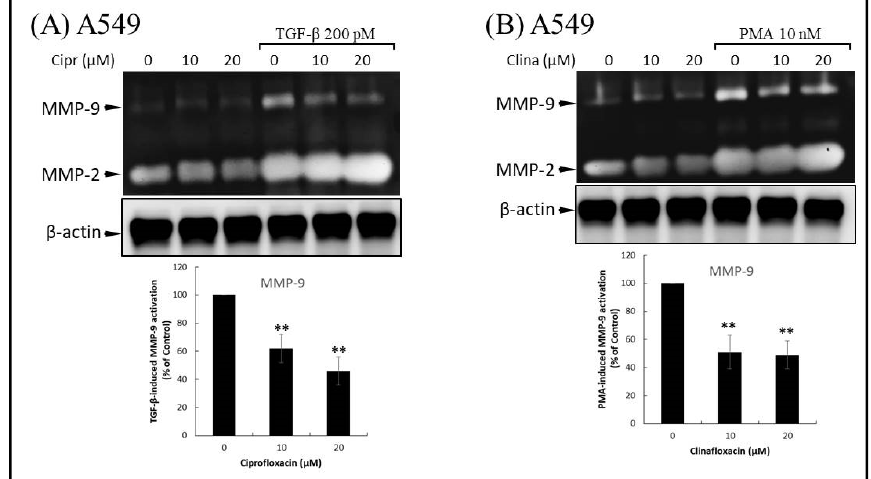
Figure 2. Fluoroquinolones (FQs) inhibit extracellular secretion of matrix metalloproteinase-9 (MMP-9). ( A ) Ciprofloxacin inhibits transforming growth factor beta (TGF- β )-stimulated gelatinolytic activity of MMP-9. A549 cells were pre-treated with ciprofloxacin for 1 h and subsequently treated with TGF- β for an additional 48 h. Conditioned medium was collected for gelatin zymography analysis of gelatinolytic activities. ( B ) Clinafloxacin reduces phorbol 12-myristate 13-acetate (PMA)-induced extracellular secretion of MMP-9. A549 cells were treated with clinafloxacin for 1 h, and then stimulated with 10 nM PMA for 24 h. Representative gelatin zymography images are shown in the upper panel. The MMP-9 activities of the FQ-treated groups were expressed as a percentage of the MMP-9 activity in TGF- β or PMA-treated cells (lower panel). The results are expressed as means ± standard deviation (error bars) of three independent experiments. Statistically significant differences of zymographic activities were indicated as percentage vs. PMA or TGF- β -stimulated control. ** p < 0.01 versus PMA or TGF- β -stimulated control experiments.